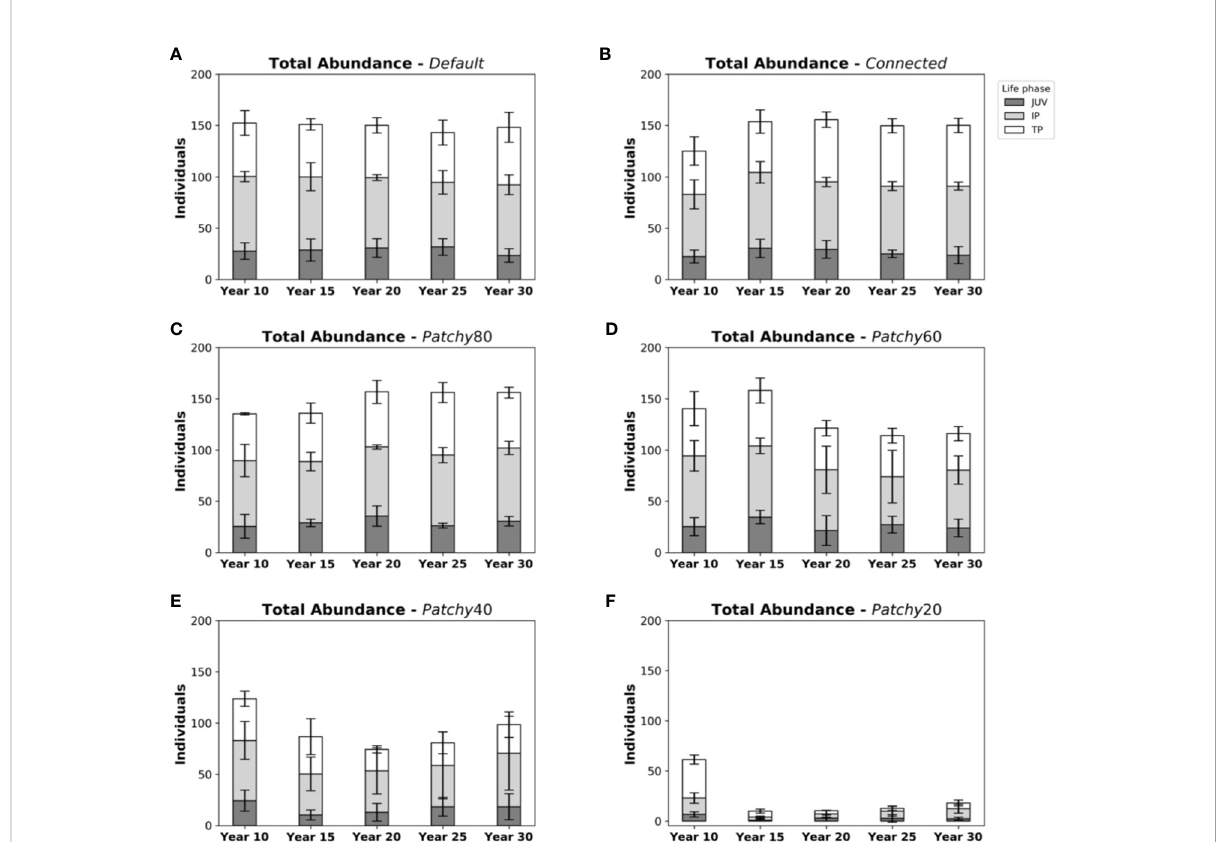
FIGURE 4 Abundances and life phase composition of model fi sh populations at different points in time during a simulation under different scenarios: (A) scenario Default , (B) scenario Connected , (C) scenario Patchy_80 , (D) scenario Patchy_60 , (E) scenario Patchy_40 , and (F) scenario Patchy_20 . Bars indicate mean values (± standard deviation (SD)) and are subdivided into life phases (JUV = juveniles, IP = (female) initial phases, TP = (male) terminal